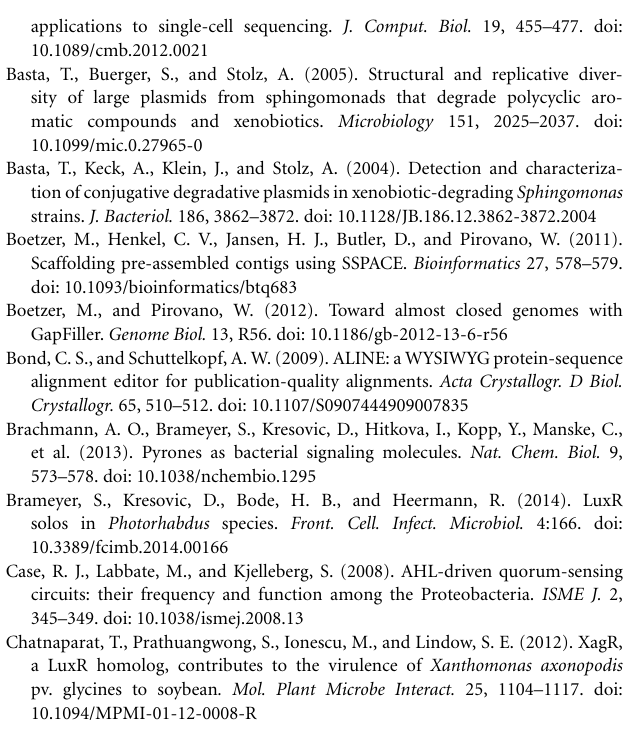
truncated LuxR protein (arrow with black star). (B) A representative Interproscan analysis domain analysis of the N-terminal truncated LuxR protein noted in Figure 7A . (C) Protein alignment of the putative LuxI solos. Number above the alignment corresponds to the amino acid residue of TraI. Amino acid residues are conserved in all LuxI-type proteins (Fuqua and Greenberg, 2002) are highlighted in